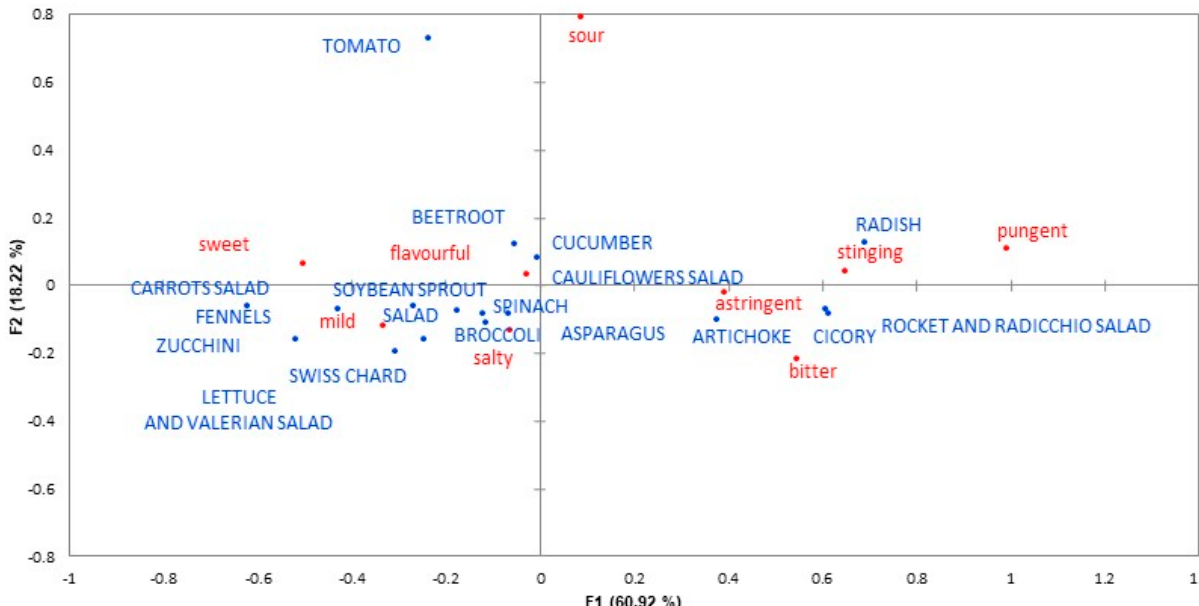
Figure 4. Representation of vegetables and sensory properties based on correspondence analysis after two factors (F1 and F2). The clusters differed in their liking for, and consumption of, phenol-rich foods (Table